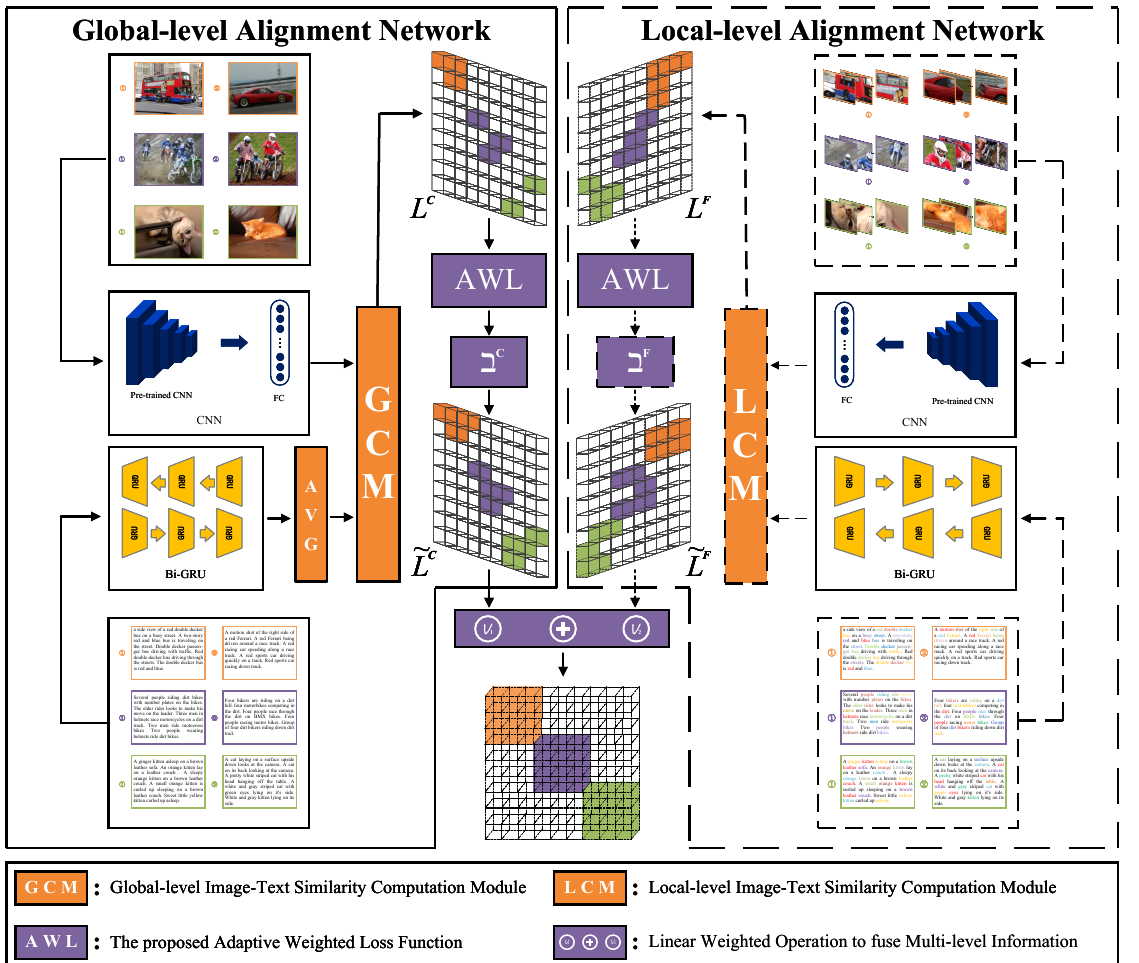
Figure 3. The overall framework of HAAN method. In general, it is composed of a global-level alignment network (shown at the left half) and a local-level alignment network (shown at the right half). Among them, GCM and LCM are designed to work out the global- and local-level image-text similarity matrix. Besides, AWL is responsible for adaptively optimizing the similarity matrix before linear weighted